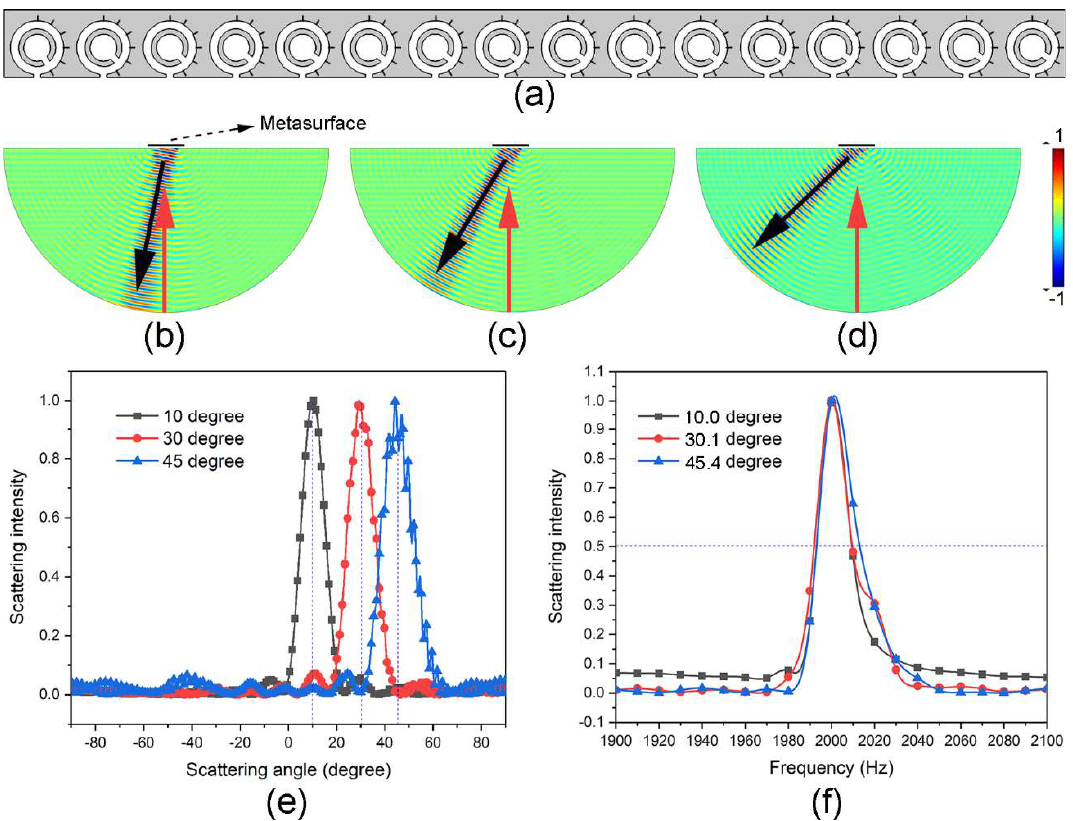
Figure 4. Tunability of the metasurface. ( a ) Schematic sketch of the metasurface for the phase gradient dϕ / dx = 0.36°/mm. The rotation angles of inner split cavities in 16 microunits are 34, 46.2, 48.8, 50, 51, 51.5, 52, 52.5, 52.9, 53.3, 53.7, 54.2, 54.7, 55.4, 56.3, and 57.6°, respectively. ( b ), ( c ), and ( d ) The normalised transient reflected fields of sound waves of the metasurface configured according to three different phase gradients, respectively, at 2000 Hz. The red and black arrows indicate the propagation directions of incident and reflected waves, separately. ( e ) Scattering field intensities of sound waves of ( b ), ( c ), and ( d ) versus scattering angle. The black, red and blue curves correspond to the target reflected angles of 10, 30, and 45°, respectively. ( f ) Scattering field intensities of sound waves of respective target angle for ( b ), ( c ), and ( d ) as a function of frequency.